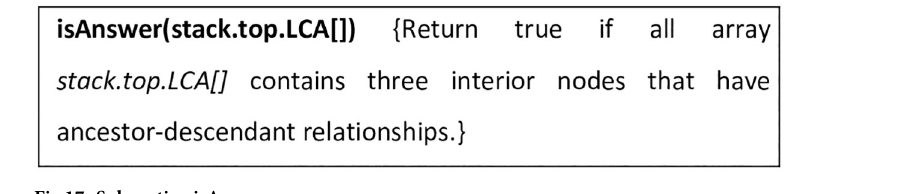
Fig 17. Subroutine